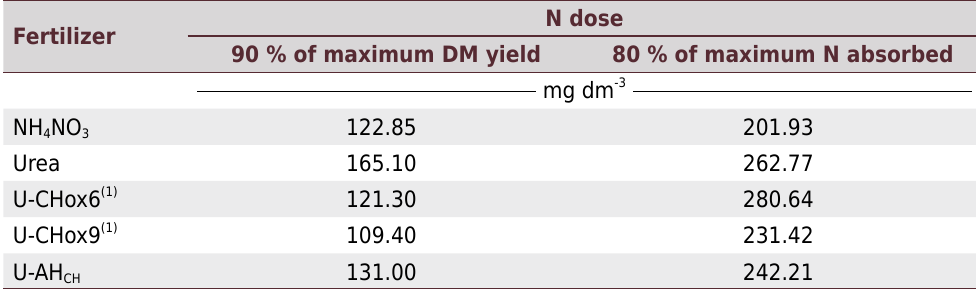
Table 7. Nitrogen dose to reach 90 % of maximum dry matter (DM) yield and 80 % of the highest amount of N absorbed. Values estimated from the adjusted regression equations for DM yield and N absorbed of corn as a function of N dosages applied as NH 4 NO 3 , urea, urea mixed with oxidized charcoals (U-CHox6, U-CHox9) or humic acids derived from CHox (U-AH CH )